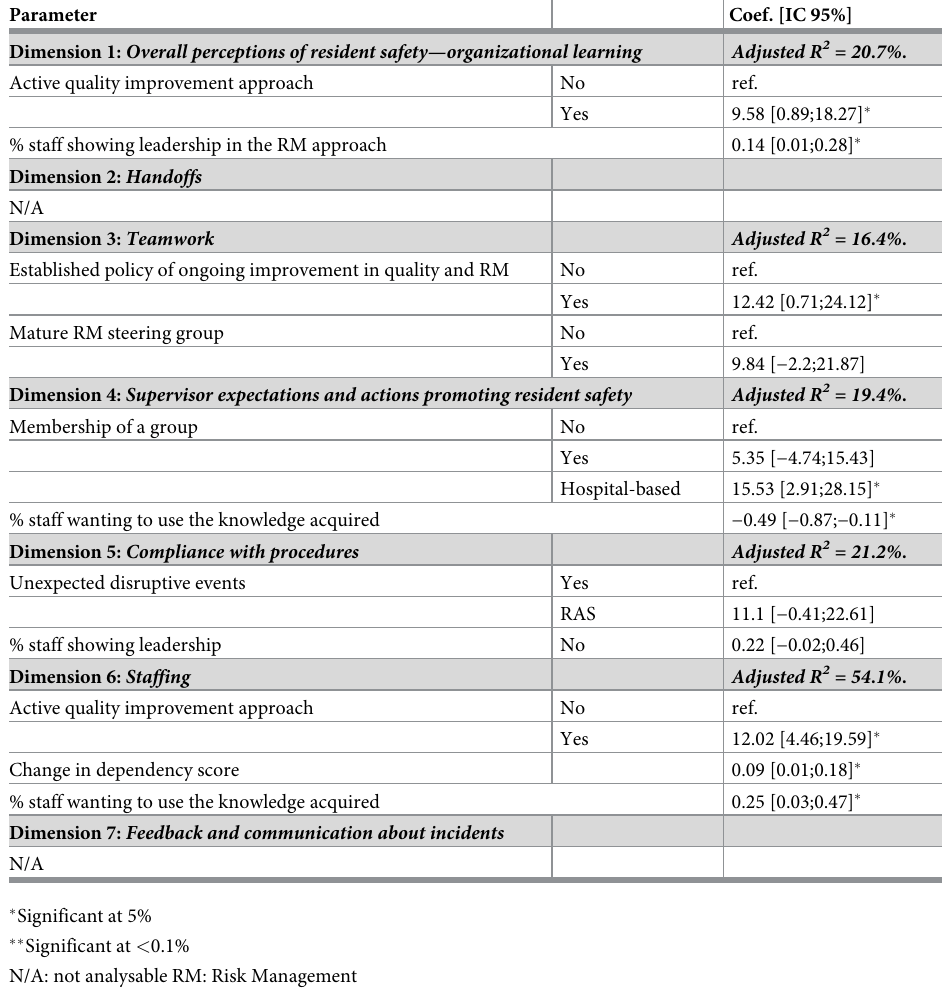
Table 4. Parameters included in the multivariate models that explain change in scores for the seven dimensions of safety culture (n = 28 NHs). Parameter Coef. [IC 95%] Dimension 1: Overall perceptions of resident safety—organizational learning Adjusted R 2 = 20 . 7%